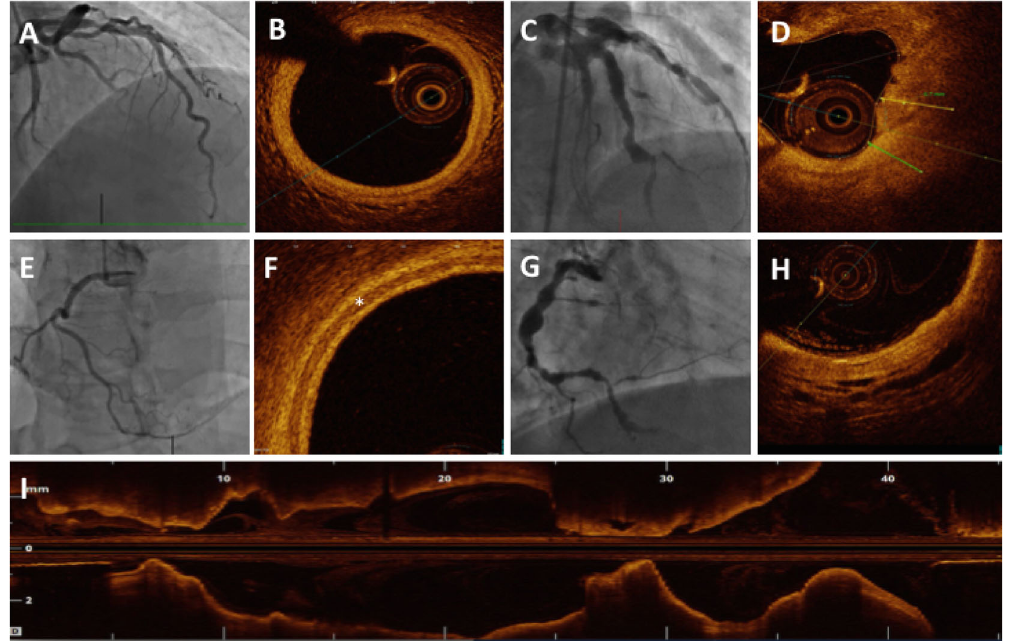
Figure 11. Optical coherence tomography. (A & E) Coronary angiogram demonstrating mild atherosclerotic disease. (B & F) OCT examination of these coronary arteries demonstrating normal intima-media where * demon- strates muscular media. (C & G) Angiography demonstrating coronary arteries many years after Kawasaki disease. OCT examination of these arteries demonstrates destroyed intima-media structure that is replaced by thick fibrosis (D) and disintegrated muscular layer (H). (I) Longitudinal reformatted OCT image of the same coronary artery demonstrated aneurysmal and stenotic segments along its length.